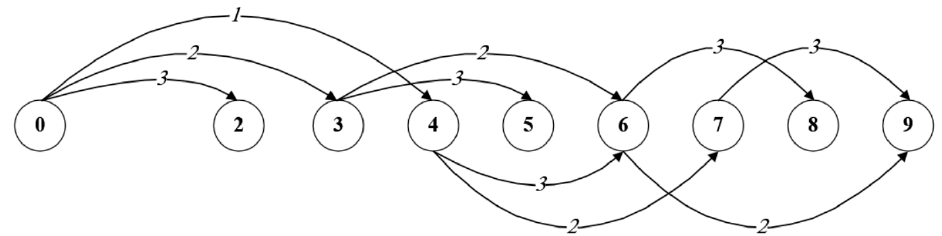
Figure 5. Graph corresponding to Example 3.